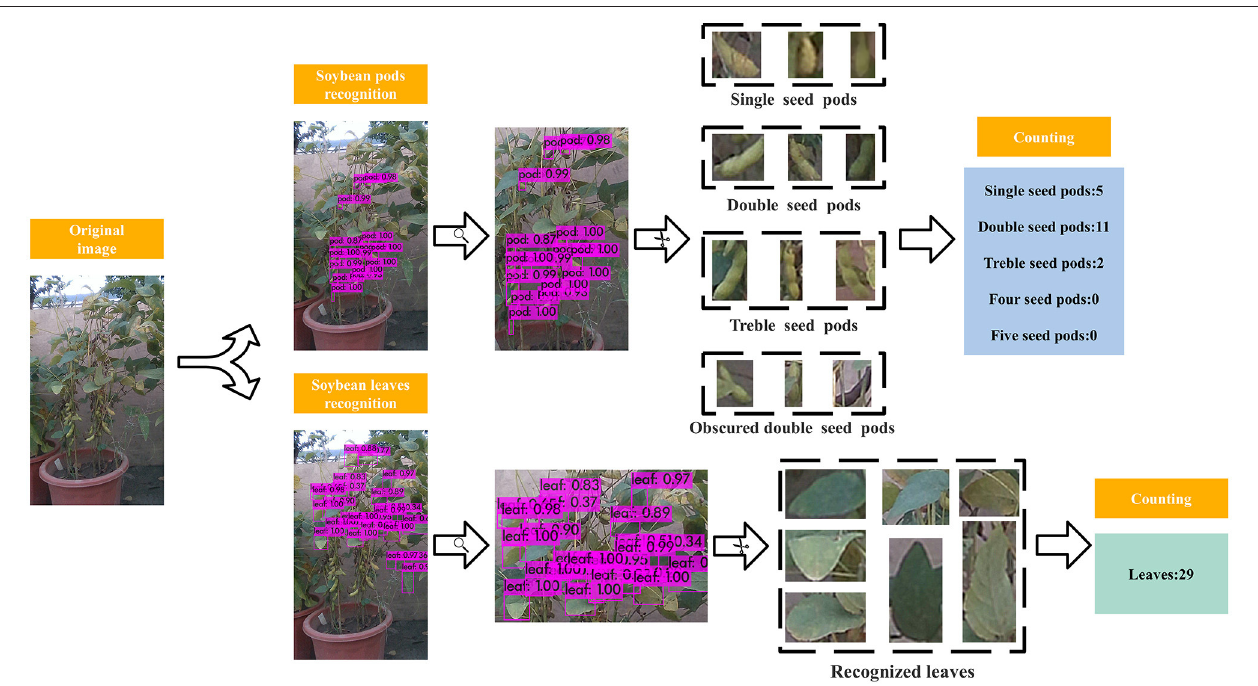
FIGURE 7 | Soybean leaves and different type pods counting process.